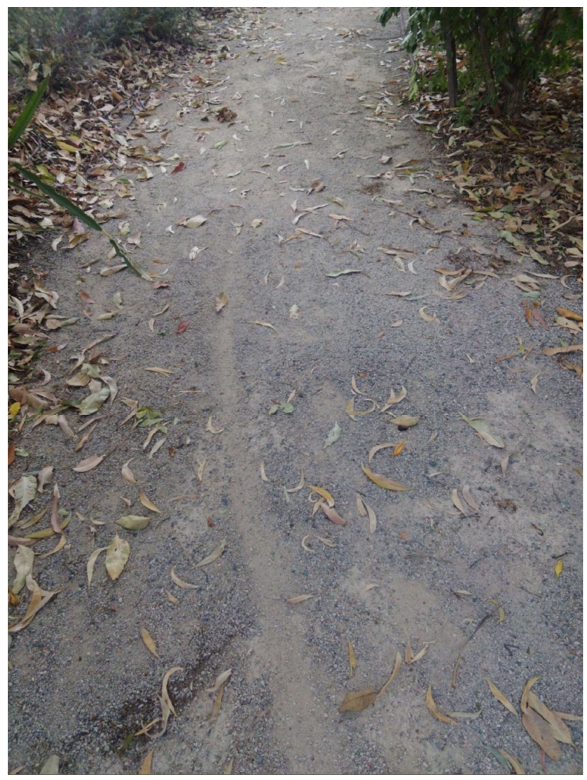
Figure 5. Loose gravel path.